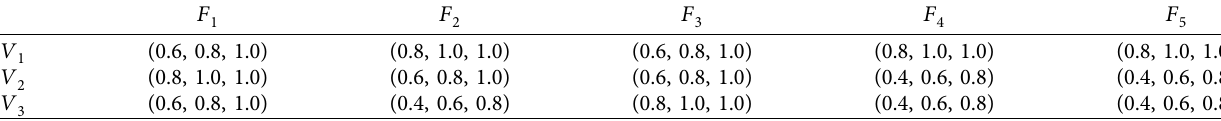
Table 2: Fuzzy preferences for the three candidates by seven experts using various criteria.